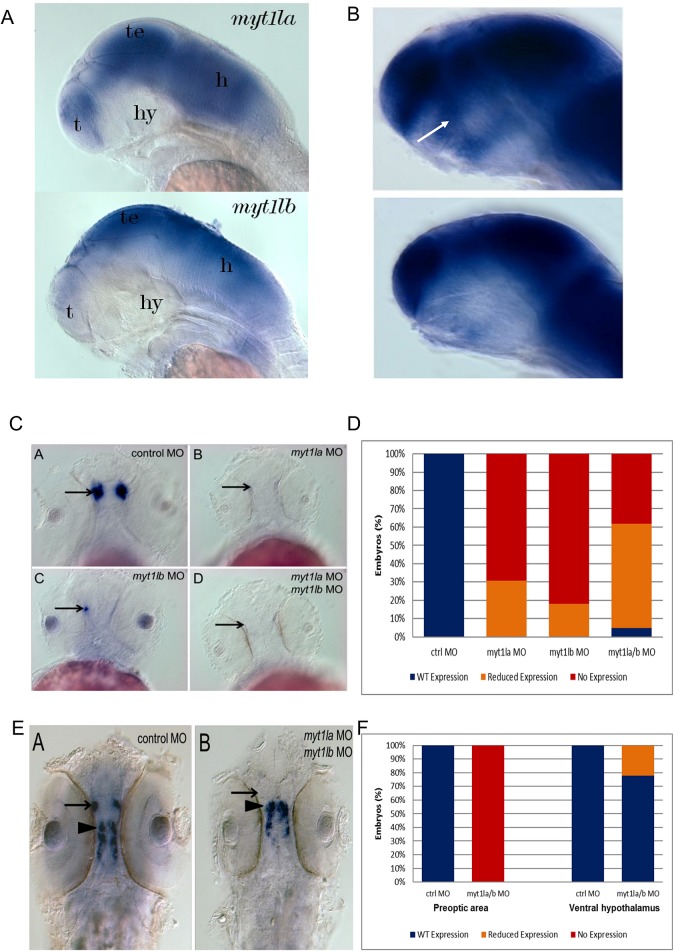
Hypothalamic peptide expression in zebrafish knockdown for MYT1L orthologues.(A)Whole mount in situ hybridization demonstrating that MYT1L orthologs myt1la and myt1lb are expressed throughout the zebrafish central nervous system. T = telencephalon, te = tectum, hy = hypothalamus, h = hindbrain. (B)Whole mount in situ hybridization demonstrating loss of myt1la expression in arnt2 mutant zebrafish, top panel shows control fish and bottom panel arnt2 mutant fish. The embryos are heavily over-stained to show the low-level expression of myt1la in the ventral diencephalon. The arrow indicates the region of the neuroendocrine preoptic area where oxytocin expressing neurons are located. (C)Whole mount in situ hybridization demonstrating that knockdown of myt1la and myt1lb, alone or in combination, results in loss of oxytocin expression in the neuroendocrine preoptic area. Arrows indicate neuroendocrine preoptic area. (D)Bar chart quantifying loss of oxytocin expression in neuroendocrine preoptic area. WISH for oxytocin was quantified as follows: ~30 cells = wild type expression, 5–15 cells = reduced, 1–4 = highly reduced, 0 = no expression (E)Whole mount in situ hybridization demonstrating that knockdown of myt1la/b results in loss of arginine vasopressin expression in the neuroendocrine preoptic region (indicated by arrow) but not the ventral hypothalamus (indicated by arrowhead). (F) Bar chart quantifying loss of arginine vasopression expression in myt1la/b morphants. WISH for arginine vasopressin was quantified as follows: ~30 cells = wild type expression, 5–15 cells = reduced, 1–4 = highly reduced, 0 = no expression.